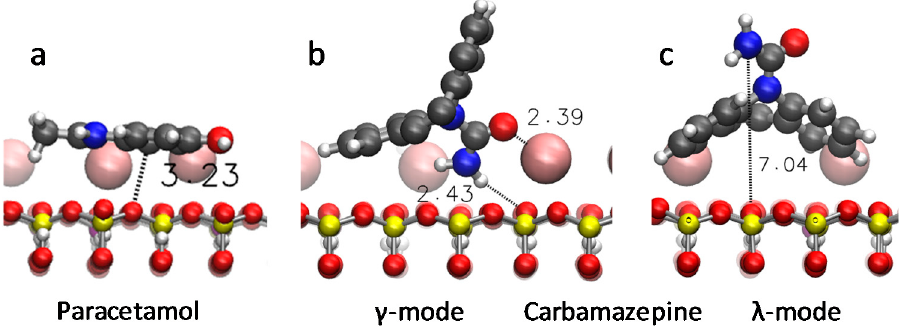
Figure 5. Representative snapshots of the adsorption of paracetamol ( a ) and carbamazepine adopting the γ -mode ( b ) and the λ -mode ( c ) on the clay surfaces. Distances are in Å. Oxygen atoms are shown in red, carbons in grey, hydrogens in light grey, silicium in yellow, and sodium cations in pink. Water molecules have been omitted for the sake of clarity.